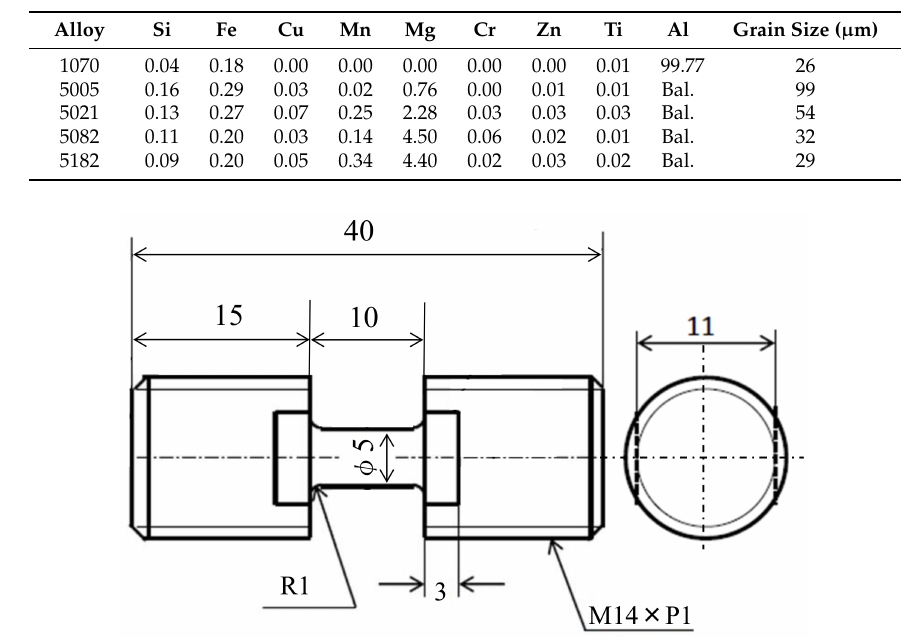
Table 1. Chemical compositions and average grain size of investigated alloys (wt.%).